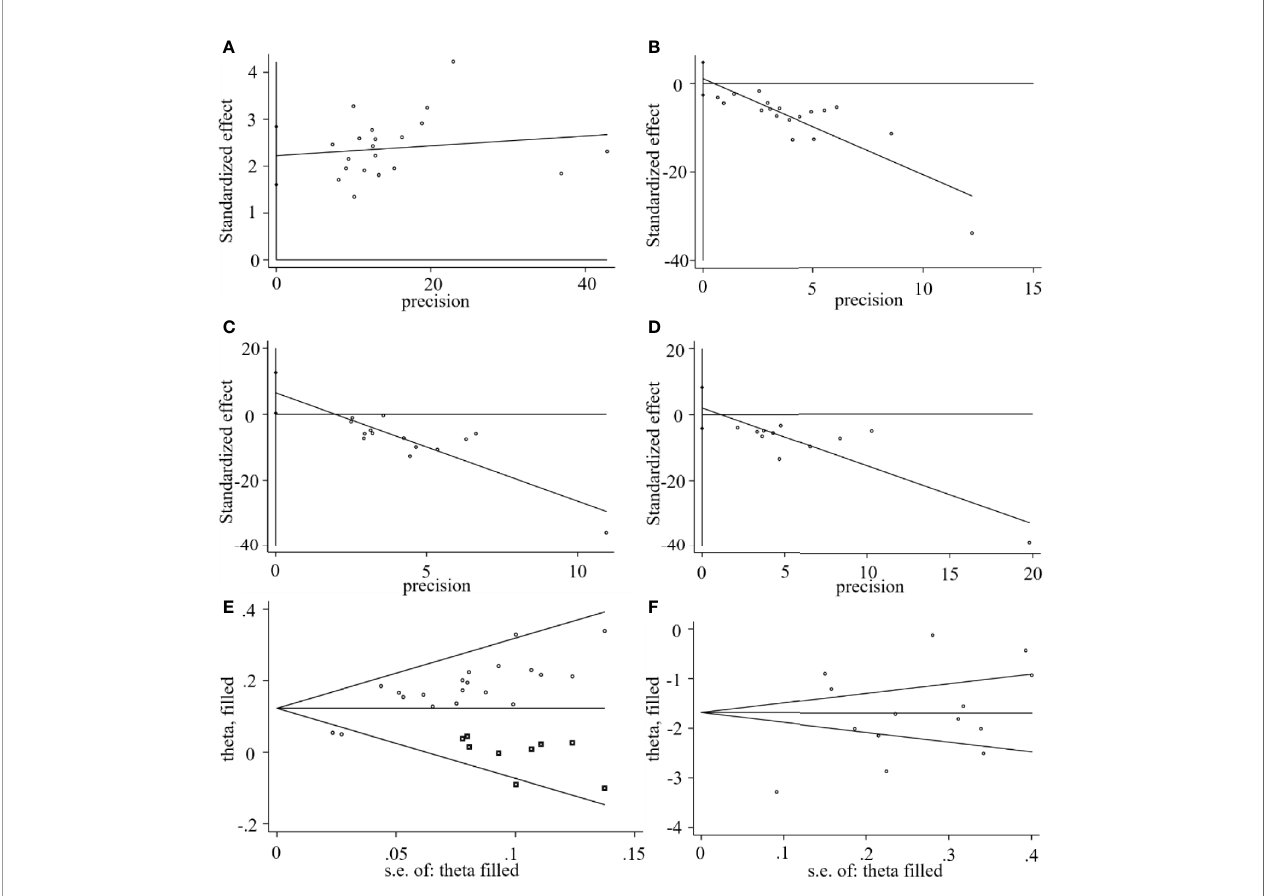
FIGURE 11 | Egger ’ s publication bias plots of the (A) CER, (B) RCT, (C) RTR, (D) RTF, and fi lled funnel plots of the (E) CER, and (F)